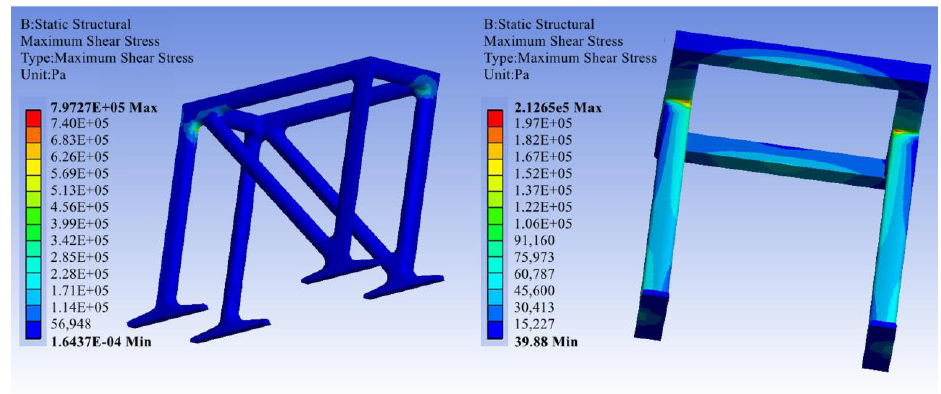
Figure 23. Stress analysis for comparison of the triangular hinge and simple straight hinge (maximum shear stress).